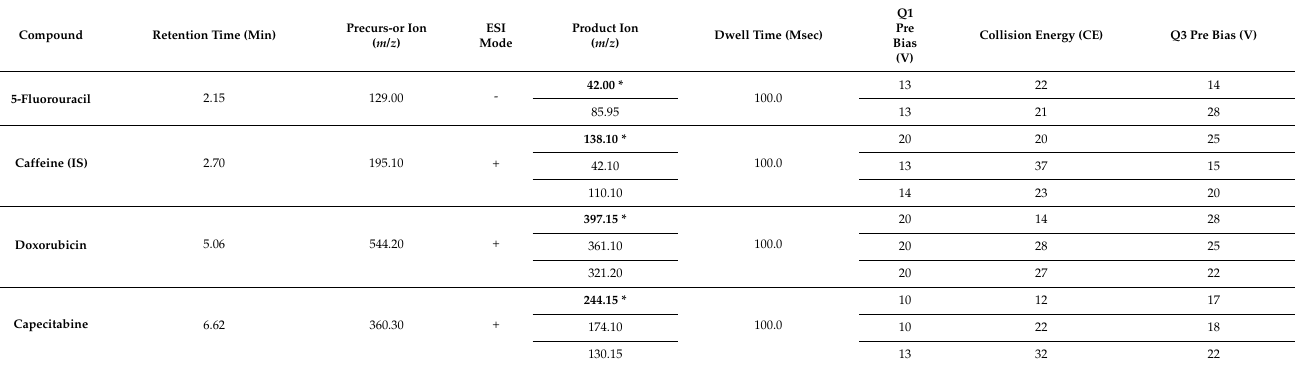
Table 1. Mass detection parameters and retention times of the target analytes and the utilized